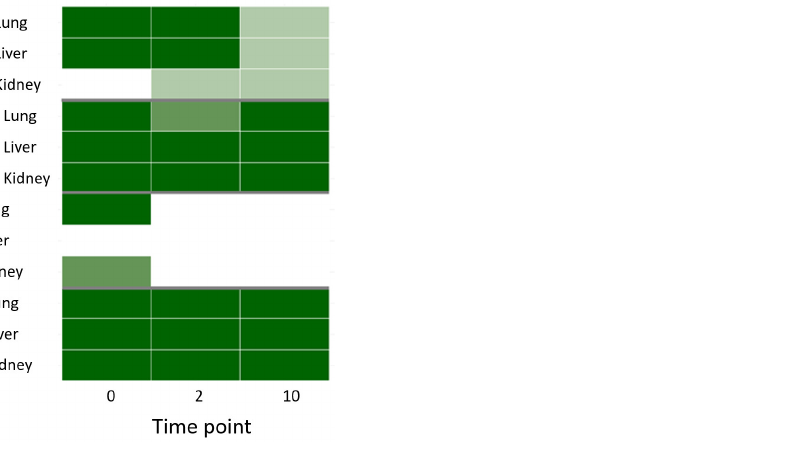
Figure 5. Concordance of qPCR and NGS. Represented are the positive viral findings in frozen (0) and FFPE samples of days 2 and 10 and examined by qPCR and NGS in one individual. They are in dark (both qPCR and NGS positive), medium (only qPCR positive) light (only NGS positive), and white (both qPCR and NGS negative).